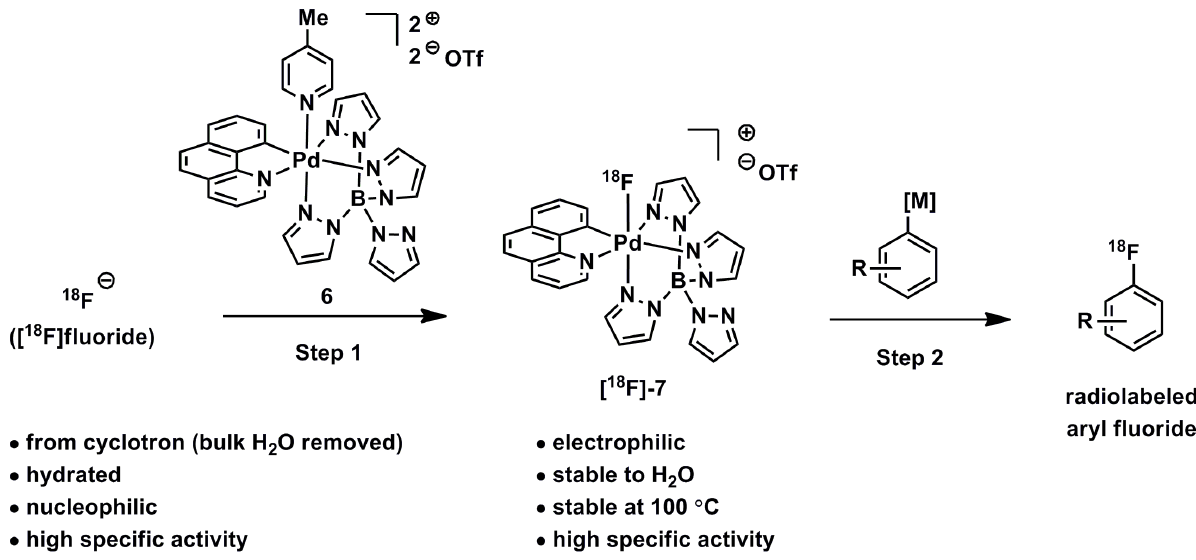
Figure 3. Two-step procedure for synthesis of radiolabeled aryl fluorides. The procedure consists of capture of [ 18 F]fluoride by palladium(IV) complex 6 to form electrophilic 18 F-fluorination reagent [ 18 F]-7 and fluorine transfer to aryl metal complexes.